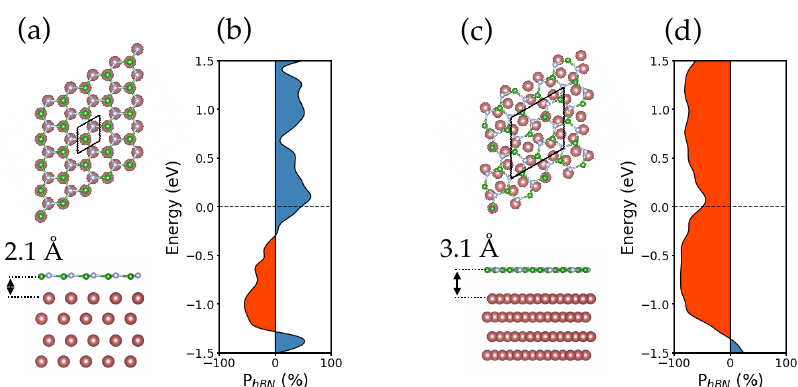
Figure 10. ( a , c ) Ball and stick representation of monolayer h -BN on Co (hcp (cid:104) 0001 (cid:105) ) within the ( a ) aligned and ( c ) misaligned ( α = 21.78 ◦ ) configurations. Boron and nitrogen atoms are colored respectively in green and white. Cobalt atoms are depicted in red. ( b , d ) Spin polarization of the density of states projected on h -BN. The excess of majority spins is colored in blue, and the excess of minority spins is colored in